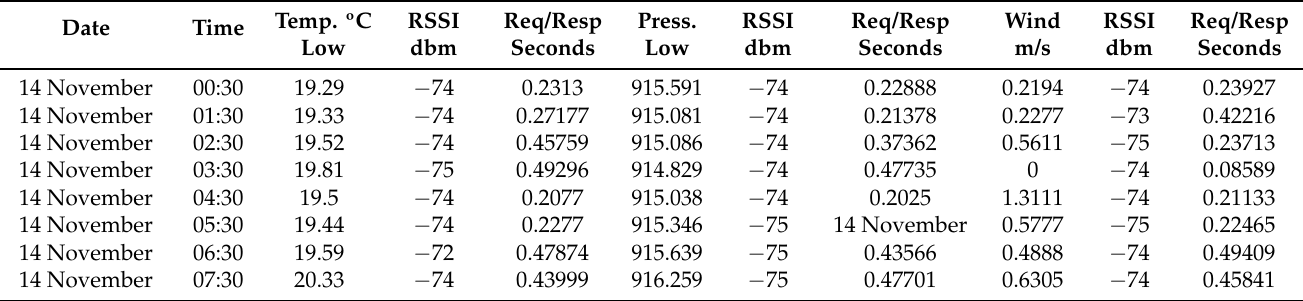
Table 1. Reading table of sensors and network